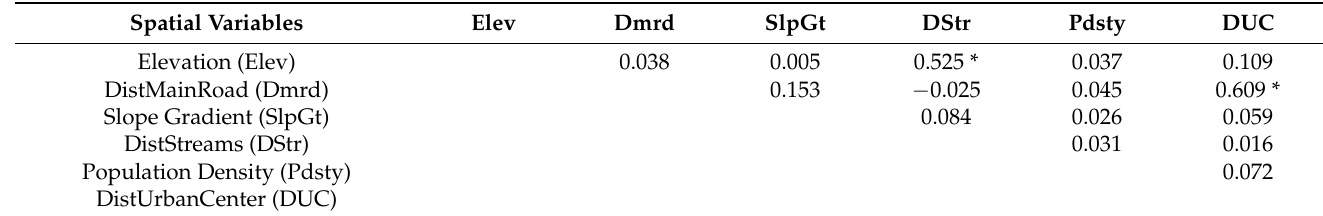
Table 7. Evaluation of the correlation between variables using Pearson’s correlation method.